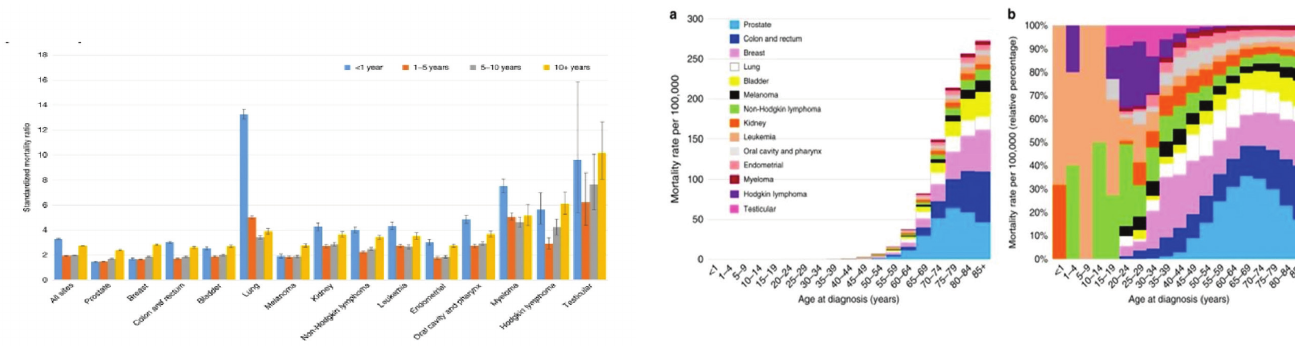
Figure 3 - Age adjusted mortality rates per 100,000 for fatal heart disease by cancer subsite. (https://www.nature.com/articles/ s41467-020-15639-5 (with the author's permission))